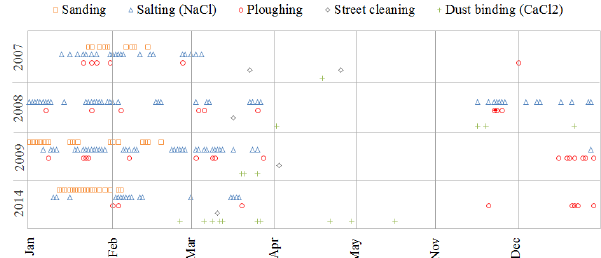
Figure 3. The approximate timing of road maintenance measures at Hämeentie for four years. All the relevant information for the latter part of the year (from October to December) was available only for